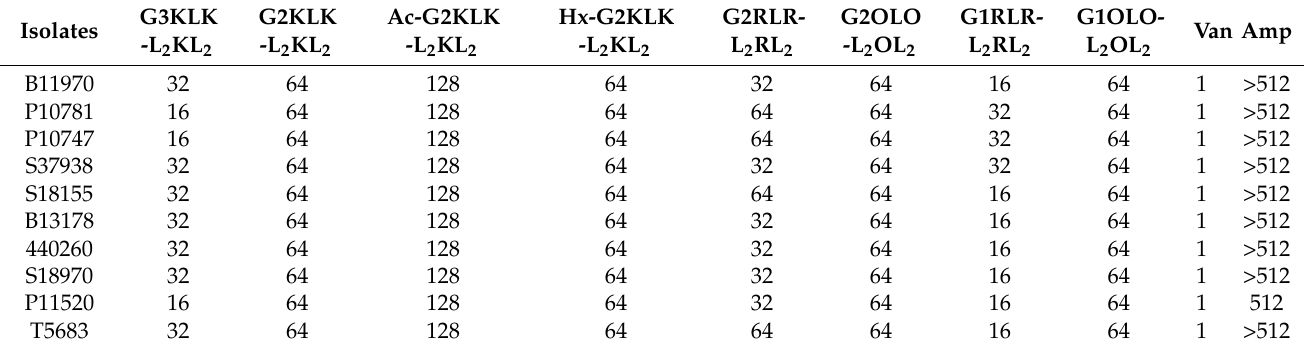
Table 3. MIC ( µ g/mL) values of the SCPDs tested on MRSA vancomycin susceptible isolates.